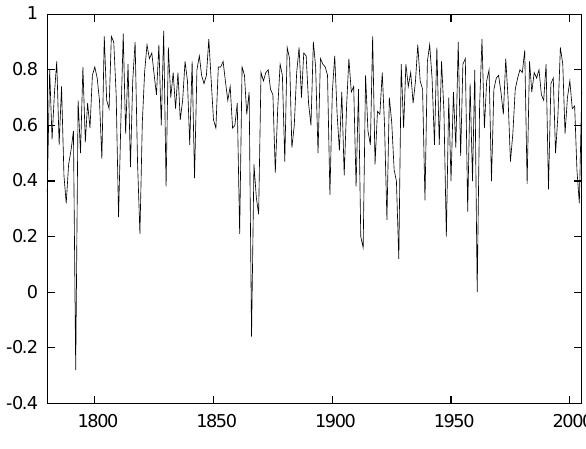
Fig. 5. Pattern correlations between fields of the simulated stream function at the 800hPa level, averaged over JFMA, and the recon- struction of stream function as derived from a SLP reconstruction.